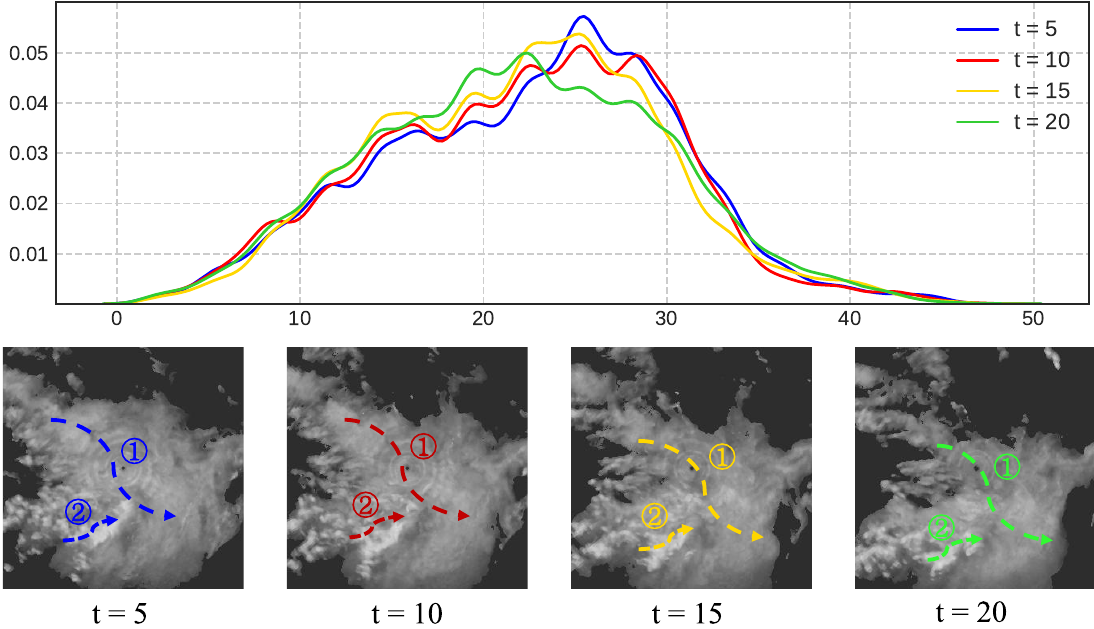
Figure 1. The changes in distribution characteristics and motion state of radar echo